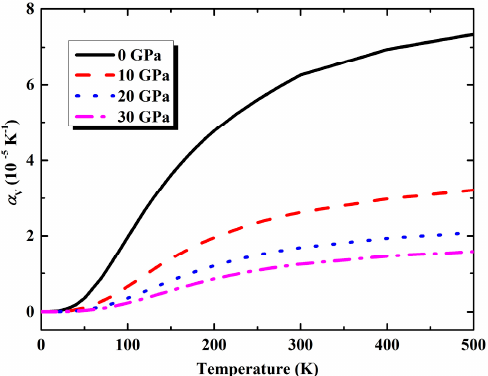
Figure 4. The calculated variation of volume coefficient of thermal expansion of K 8 Si 46 with temperature under 0, 10, 20 and 30 GPa.